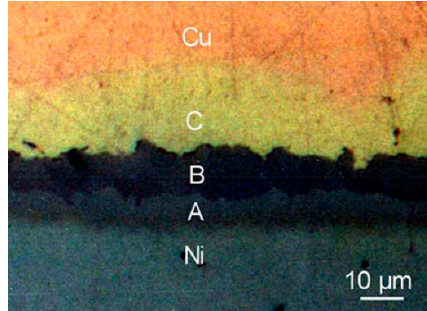
Figure 5. Optical microscope image of the Cu/Al-Ga-Ni paste/Ni bond cross section [66]. A, B, and C are α ’-Ni 3 Ga, β -Cu 3 Ga, and Cu solid solution phase, respectively.